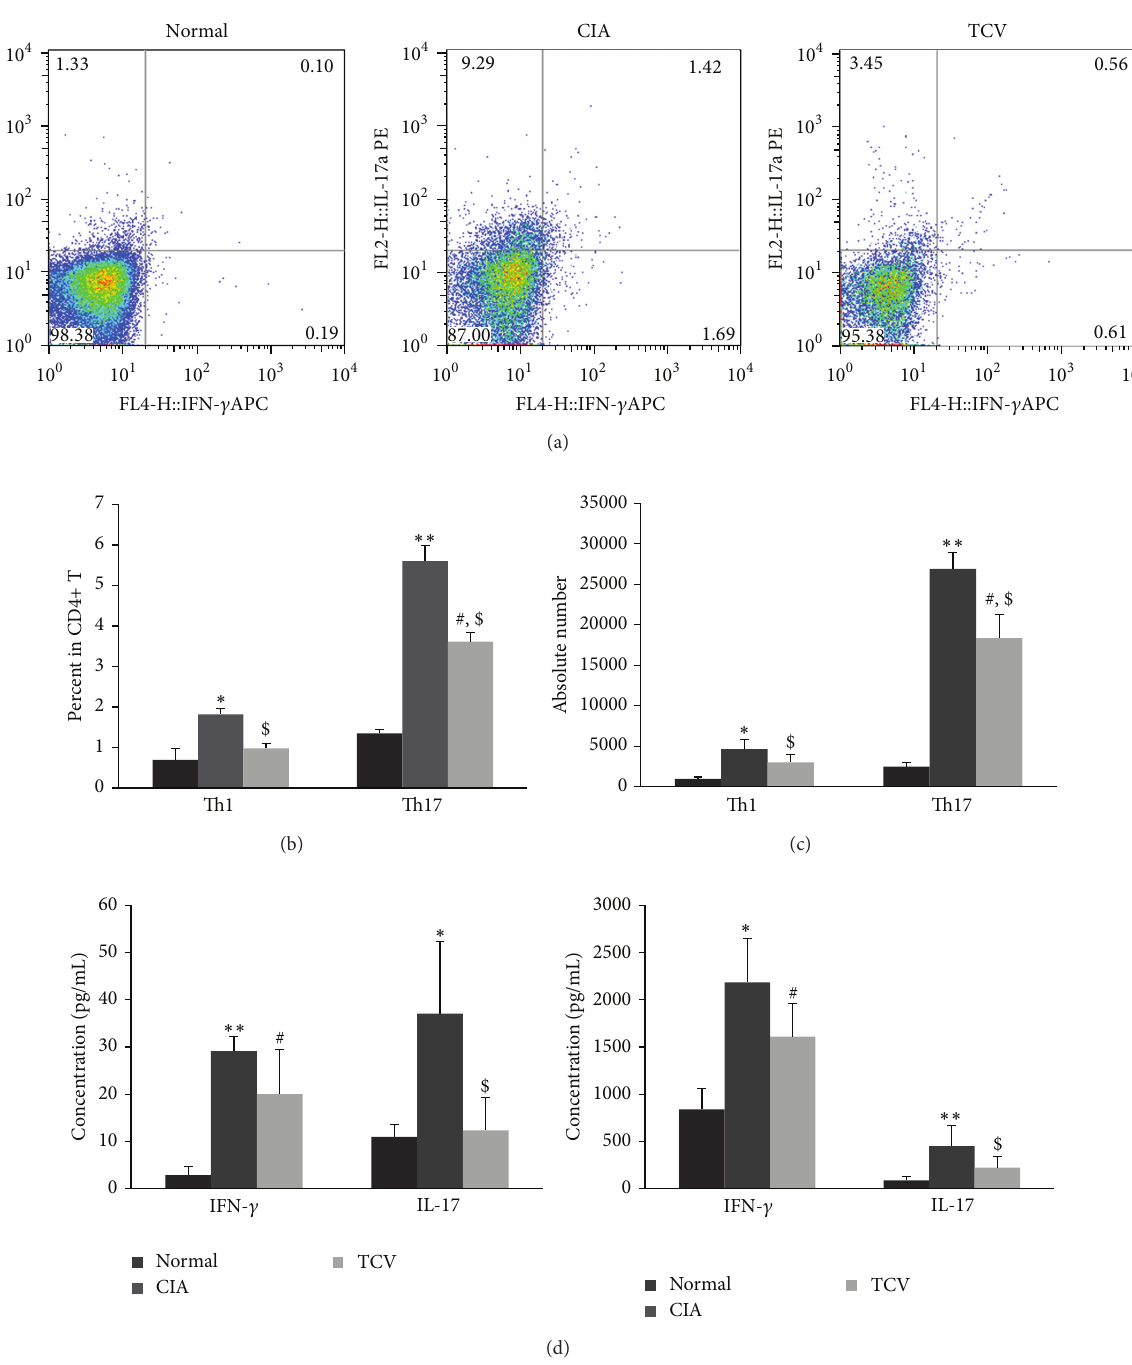
Figure 2: TCV influenced the frequency of Th1/Th17 cells and related cytokines in CIA mice. The three groups of mice were sacrificed at the peak of the disease. DLN MNCs were harvested. IFN- 𝛾 and IL-17 secreting cells were determined by intracellular staining and flow cytometry. Results showed the percentage of Th1/Th17 cells in DLN CD4+ cells (a)-(b). (c) Results showed the absolute number of Th1/Th17 cells in DLN. (d) Heart blood was collected and the serum was isolated by centrifuge. DLN MNCs were prepared and incubated (5 × 10 5 cells/well) in the absence and presence of heat-inactivated CII (20 𝜇 g/mL) for 48h and the supernatants were collected. The levels of IFN- 𝛾 and IL-17 were determined using ELISA. Concentration of IFN- 𝛾 and IL-17 in sera (left) and supernatants of cell culture (right). Data are represented as means ± SD ( 𝑛 = 10 mice/group). Data are representative of 5 separate experiments with similar results. ∗ 𝑃 < 0.05 , ∗∗ 𝑃 < 0.01 , CIA versus normal group. # 𝑃 < 0.05 , TCV versus normal group. $ 𝑃 < 0.05 , TCV versus CIA